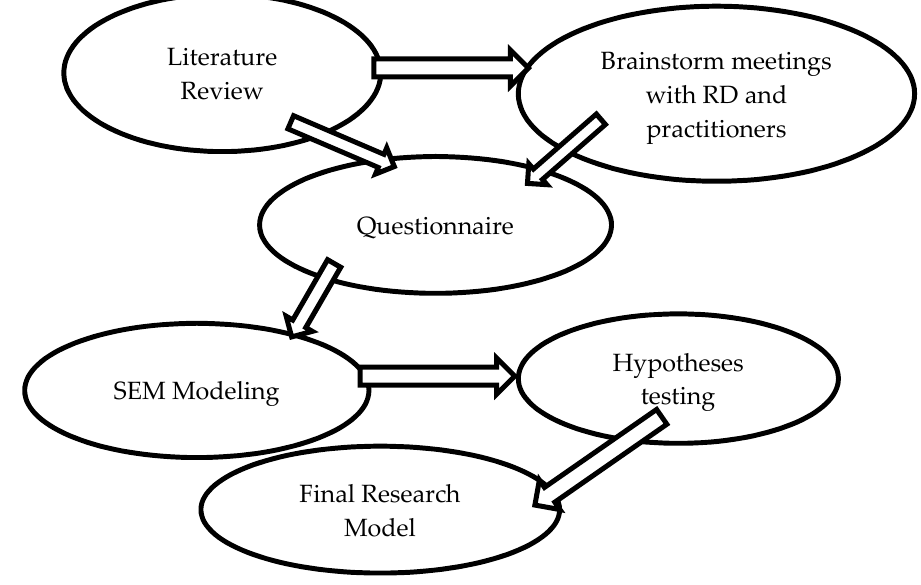
Figure 1. Model of data analysis procedures.